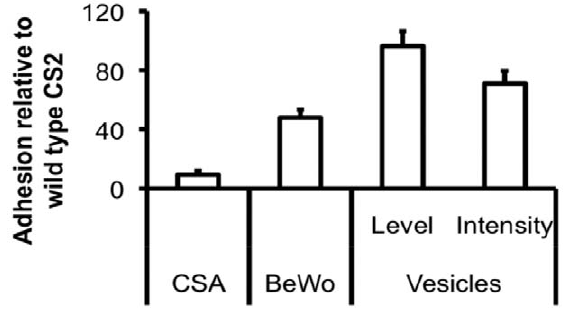
Figure 6. Adhesins other than VAR2CSA support adhesion to the placental epithelium. CS2 IE with disrupted var2csa were selected on BeWo cells for adhesion. In comparison to wild type CS2 IE, they bound at very low levels to isolated CSA. Their adhesion to the BeWo placental cell line was about half that of the wild type IE. However, in our vesicle adhesion assay, this BeWo-selected var2csa KO showed similar percentages of IE bound to vesicles (p=0.7728) as well as comparable adhesion intensity (p=0.2454) to wild type CS2. All results are normalised to wild type levels and represented as mean and standard